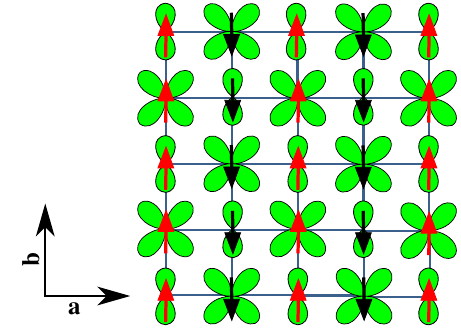
FIG. 2. Schematic view of C -AF spin order coexisting with G -AO orbital order in the ð a; b Þ plane of an undoped Mott insulator with 4 d 4 ionic configurations. Spins are shown by arrows, while doubly occupied xy and yz orbitals ( c and a doublons; see the text) form a checkerboard pattern. Equivalent spin-orbital order is realized for V 3 þ ions in the ð b; c Þ planes of LaVO 3 [56], with orbitals standing for empty orbitals